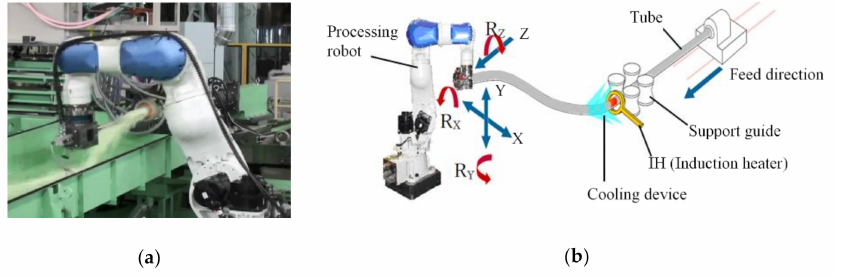
Figure 1. Three-dimensional hot bending and direct quench (3DQ) machine: ( a ) appearance photograph and ( b ) schematic illustration.